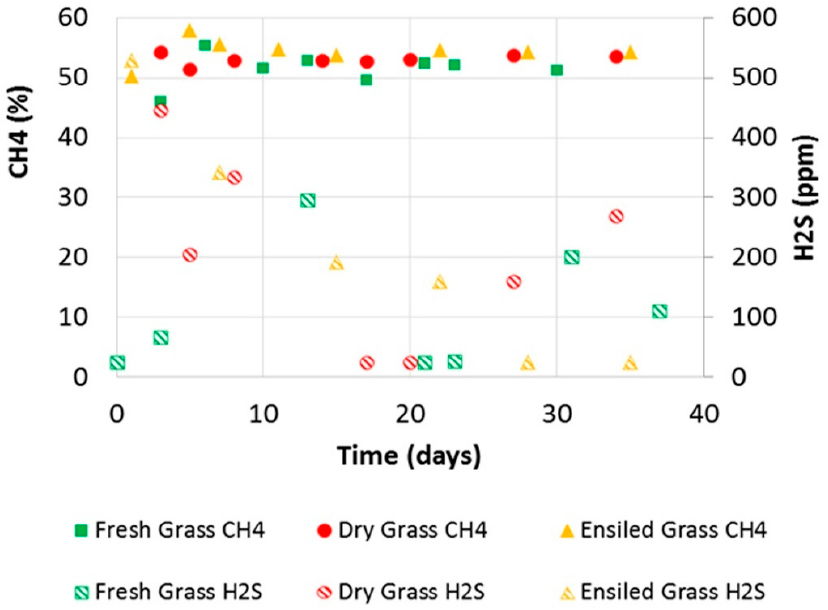
Figure 3. Biogas quality in terms of CH 4 , CO 2 , and H 2 S concentration, for fresh, dry and ensiled grass.